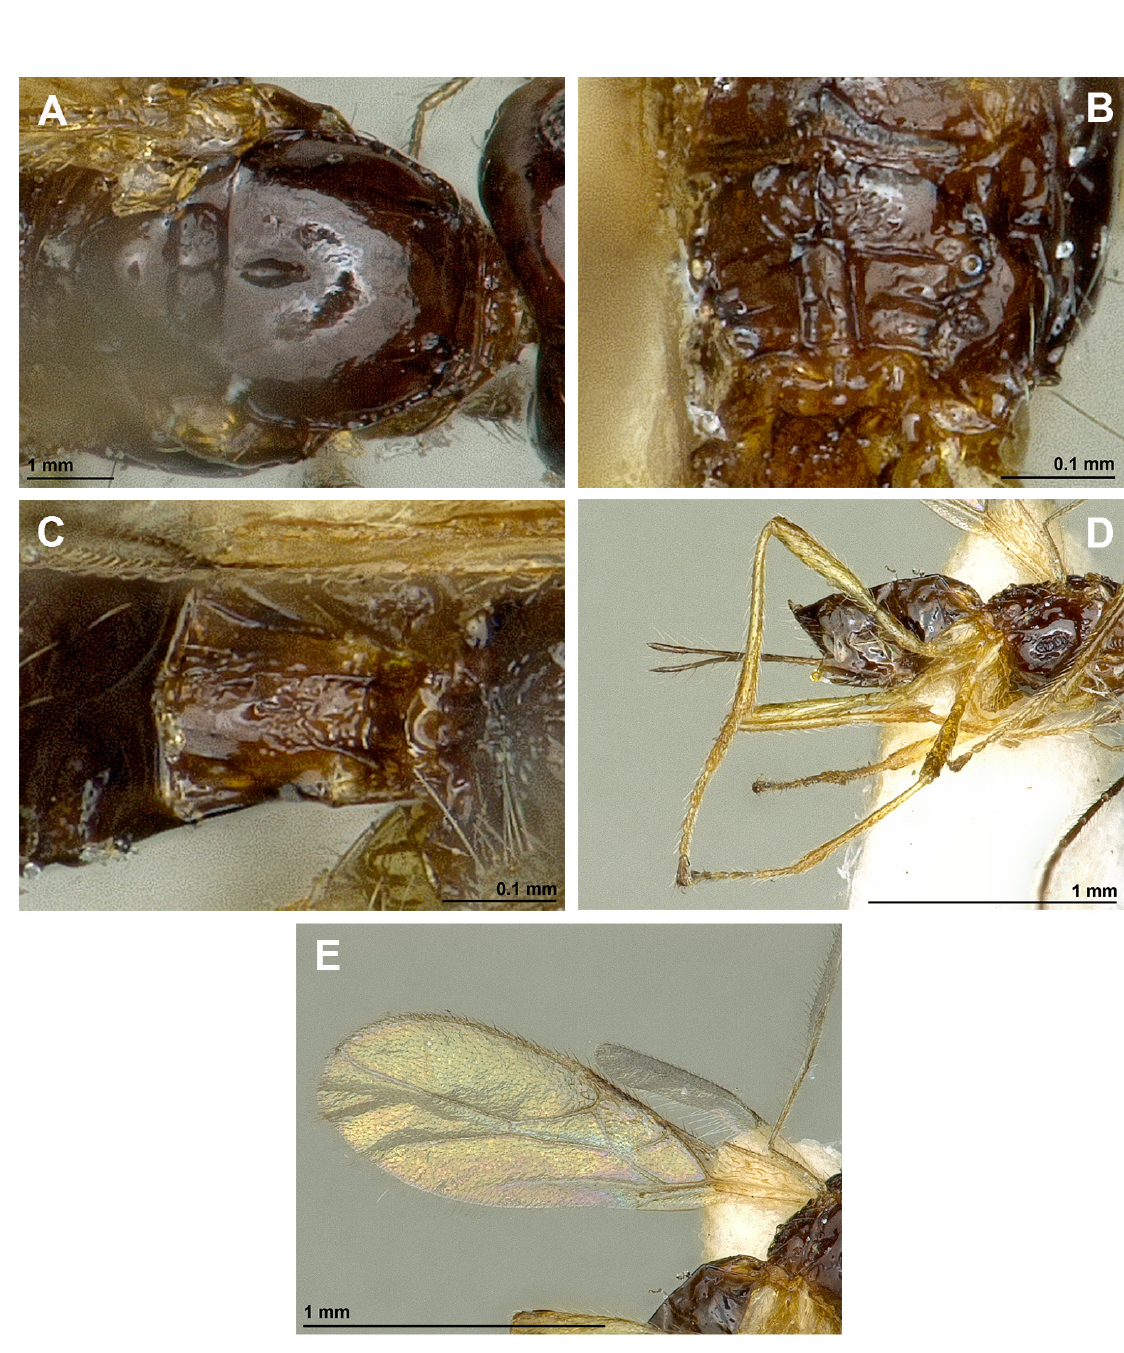
Fig. 24. Asobara harrinsmithensis Peris-Felipo, sp. nov., ♀, holotype (BMNH 1927-147). A . Mesoscutum, dorsal view. B . Propodeum, dorsal view. C . First metasomal tergite, dorsal view. D . Hind leg, metasoma and ovipositor, lateral view. E . Fore and hind